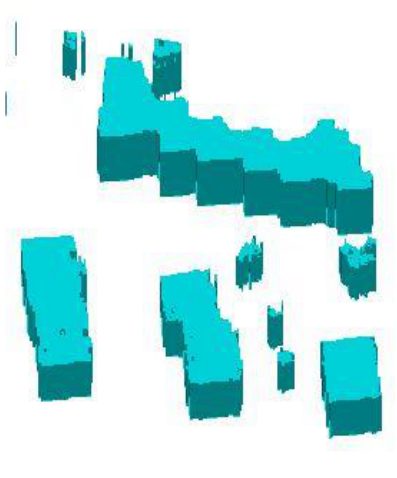
Figure 4- LoD1 3D CityGML model created by LiDAR data and building foot print extracted by raster images